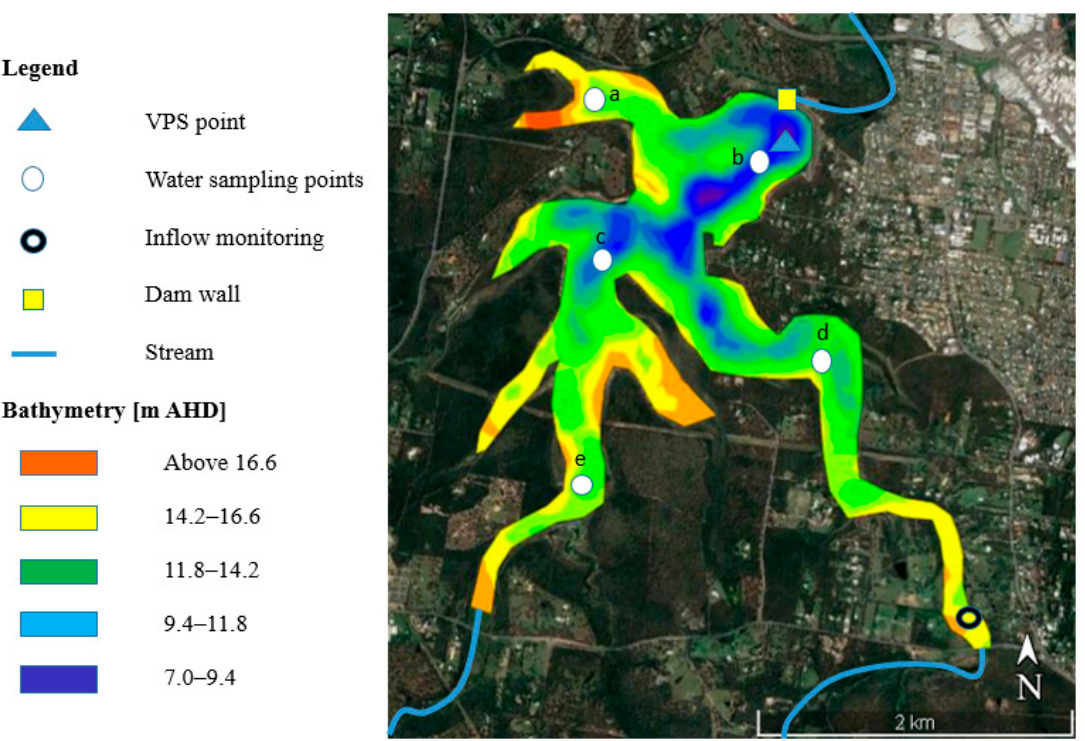
Figure 1. Monitoring sites in Tingalpa Reservoir. In the background, the bathymetry [m AHD] of Tingalpa Reservoir is presented.